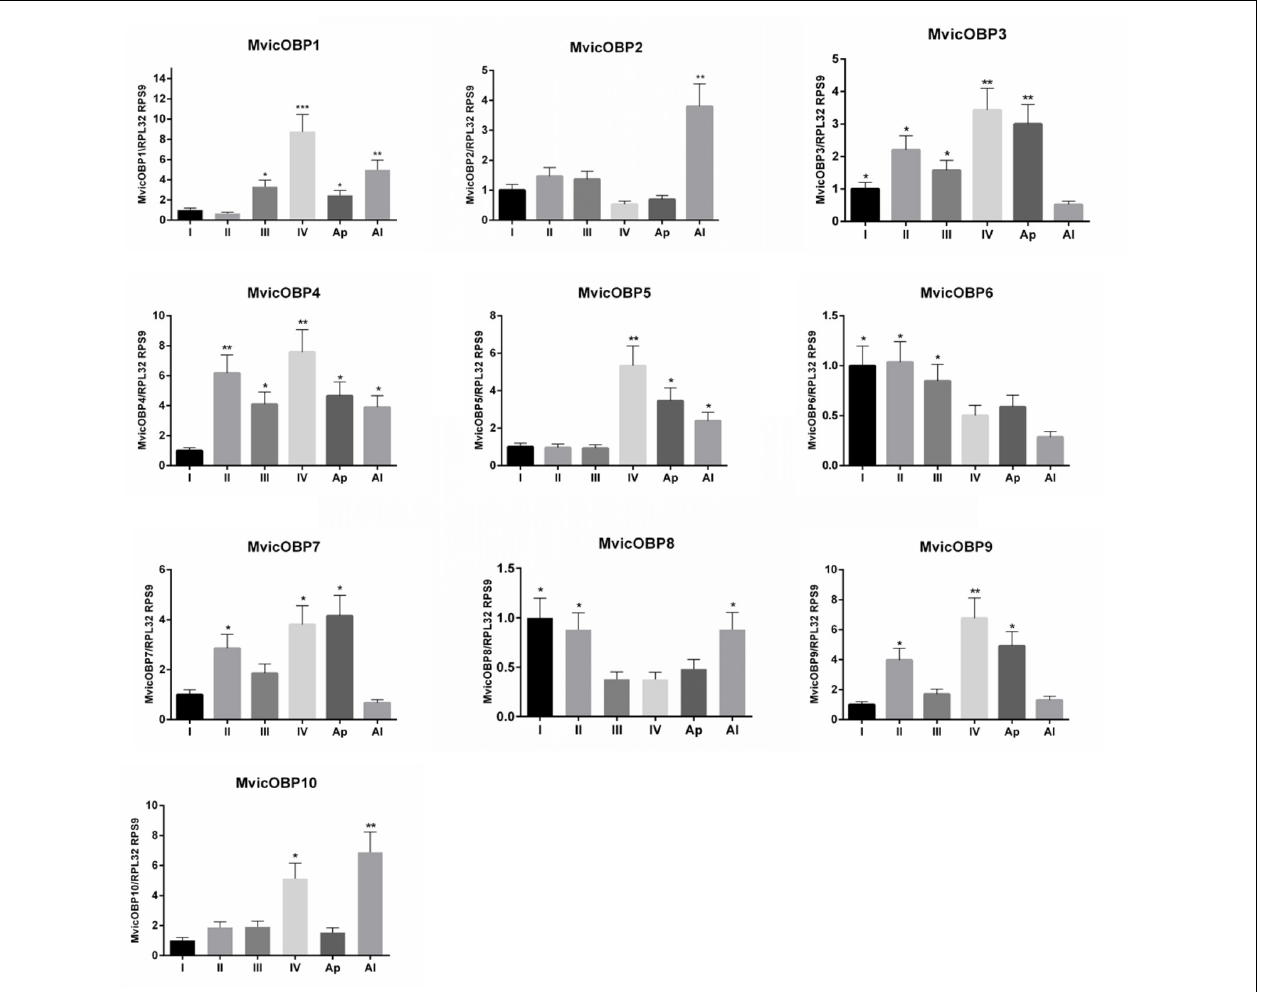
FIGURE 5 | Relative expression level of M. viciae OBPs in different nymphal instars. OBP expression levels were quantified by RT-qPCR. Bars represent the standard deviation of the mean for 3 independent experiments. Significant differences are denoted by asterisks (Tukey’s test, ( ∗ p < 0.05, ∗∗ p < 0.01, ∗∗∗ p < 0.001)). I, 1st nymphal instar; II, 2nd nymphal instar; III, 3rd nymphal instar; IV, 4th nymphal instar; Ap, winged adults; Al, winged adults. Reference genes: RPL32 , RPS9 . Calibrator sample: 1st nymphal